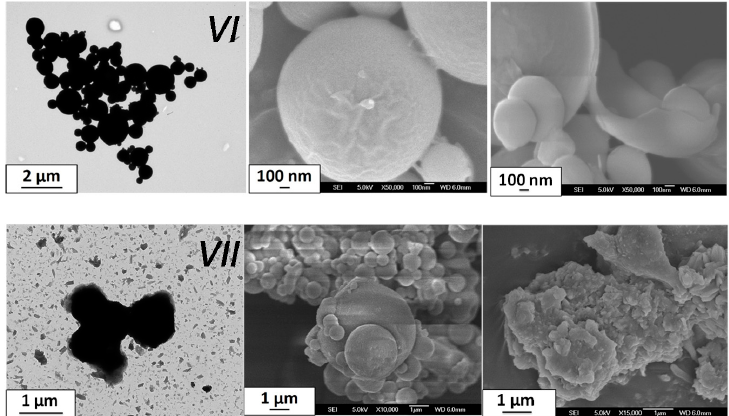
Figure 6. TEM and SEM images of the particles obtained from spray-drying for the selected batches VI and VII for trials to get [Fe(Htrz) 2 (trz)](BF 4 ).